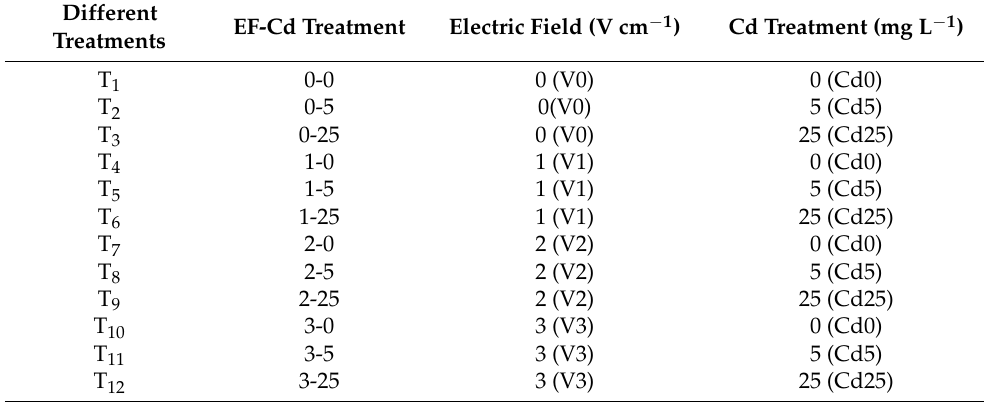
Table 1. The treatments in the